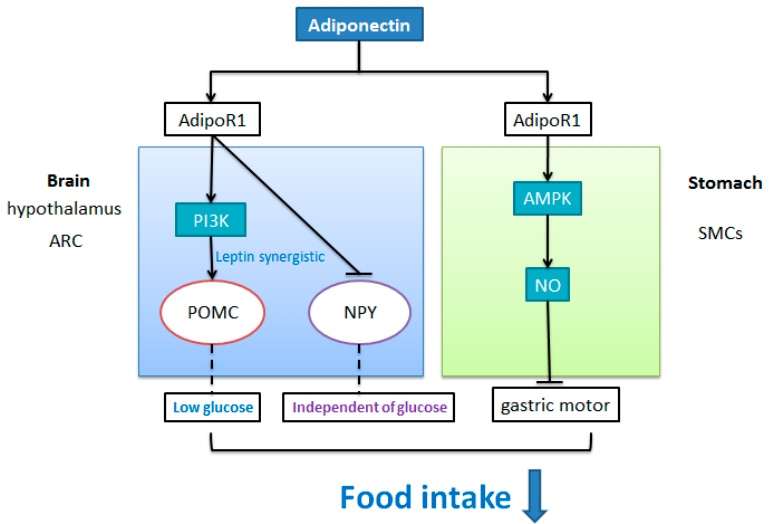
Figure 3. The inhibitory effect of adiponectin on food intake. In the arcuate nucleus of the hypothalamus, adiponectin may bind to AdipoR1 in the arcuate nucleus of the hypothalamus to stimulate the depolarization excitation of POMC neurons and inhibit the excitation of NPY/AgRP neurons, thus inhibiting food intake. The activation effect of AdipoQ on POMC neurons was closely related to low glucose concentration, PI3K and Leptin, but not to AMPK pathway. In addition, AdipoQ’s inhibitory effect on NPY neurons was independent of glucose concentration. Existing studies have in the peripheral confirmed that adiponectin can activate AMPK signaling pathway to promote NO release through binding with AdipoR1 in the basal part of the stomach, thus inhibiting food intake.